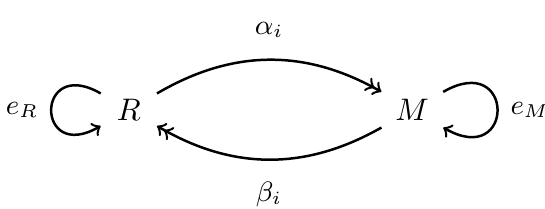
Figure 2 . The conifold quiver. e i is the idempotent of node i = R; M in the path algebra of the quiver.